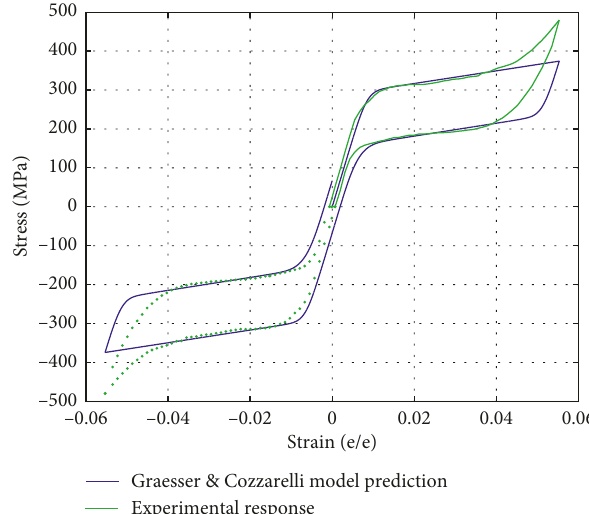
� 0 (shape-memory effect) and (b) f t